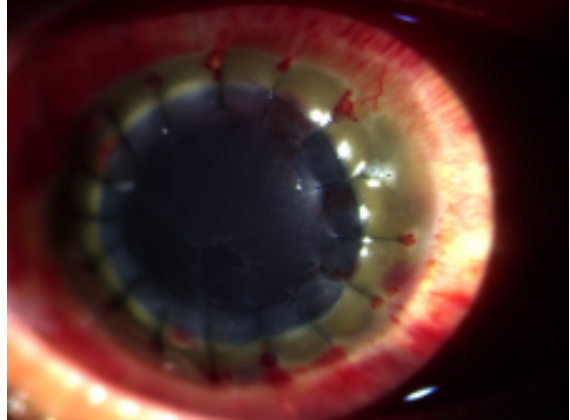
Figure 2: Postoperative day 3 slitlamp examination of the right